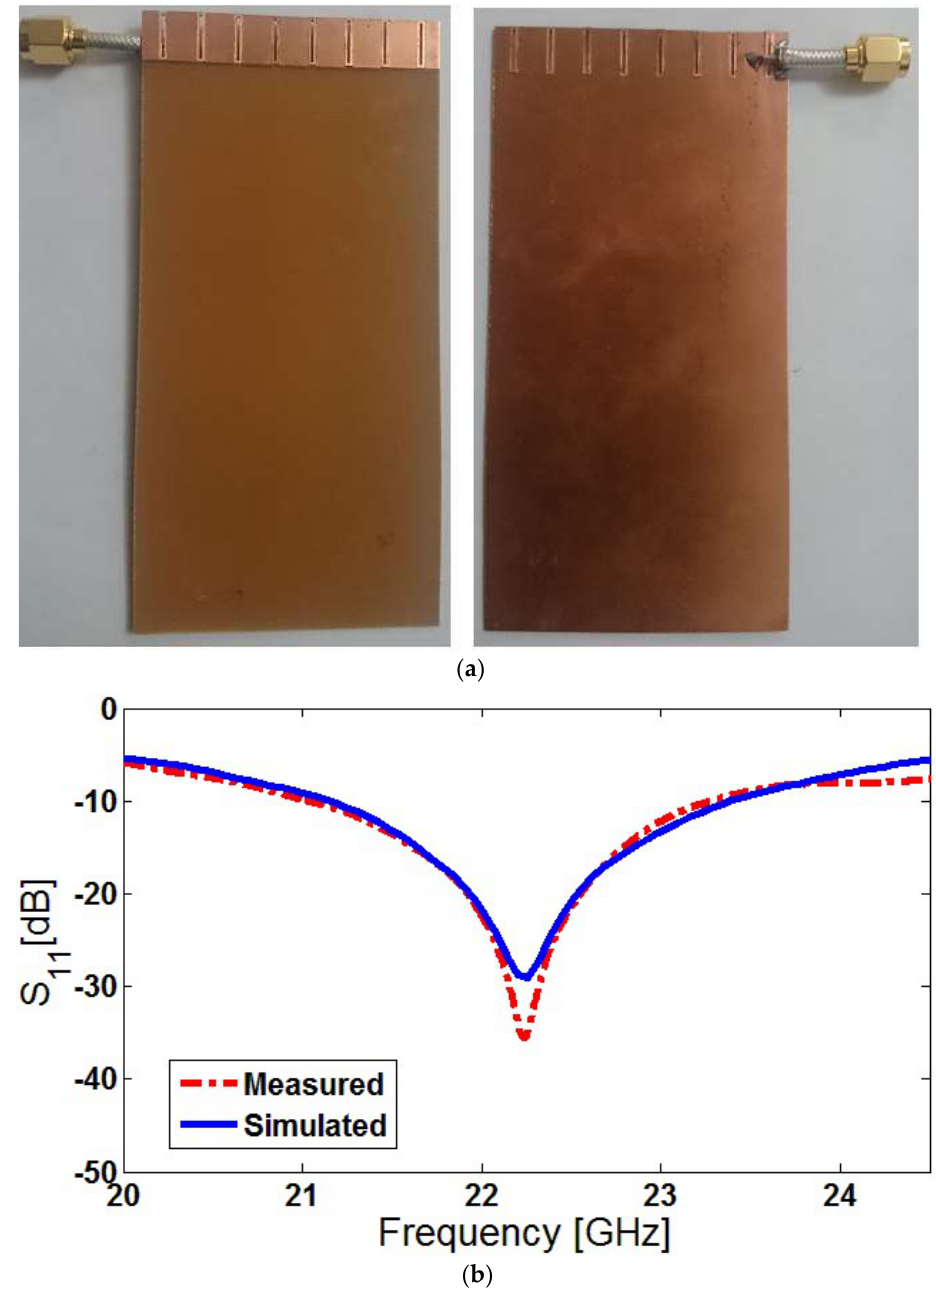
Figure 20. ( a ) Fabricated prototype sample with the coaxial feeding mechanism of the element and ( b ) measured/simulated comparison for the antenna reflection coefficient (S 11 ).